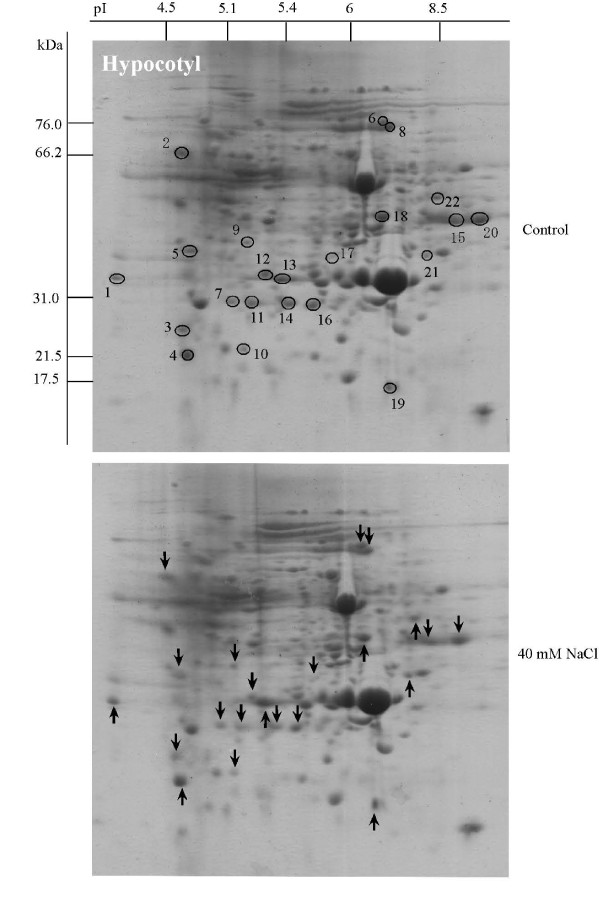
Protein expression patterns in the hypocotyl of soybeans treated with NaCl. Seeds were sown and treated with 40 mM NaCl. After 7 days, proteins were extracted from the hypocotyl separated by 2-DE, and visualized by CBB staining. The pI and Mr of each protein were determined using 2-DE markers (Bio-Rad). Arrows indicate protein changes due to NaCl treatment, and circles mark the position of the same proteins from the control. Upward arrows indicate up-regulation and downward arrows indicate down-regulation.